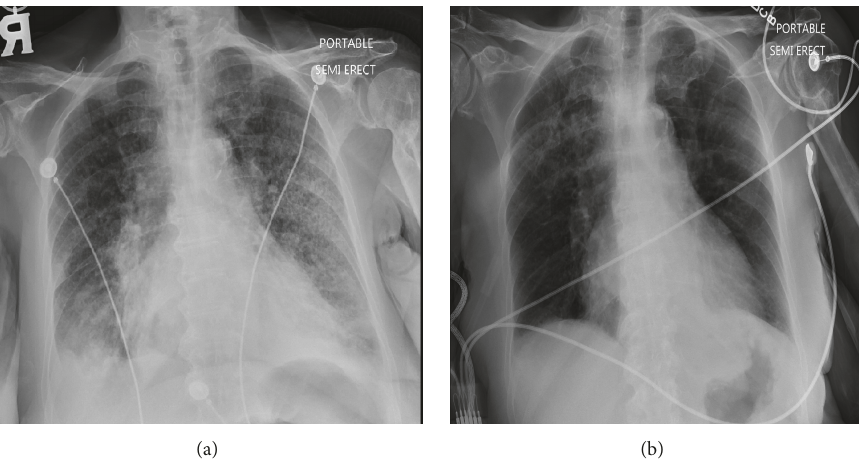
Figure 1: (a) CXR on admission showing bilateral small pleural effusions and infiltrates. (b) CXR 48 hours after diuresis showing resolving infiltrates.